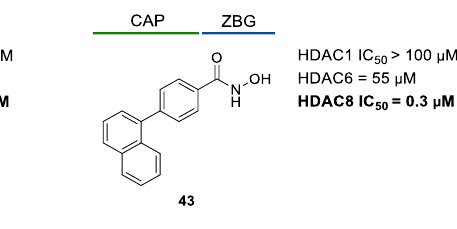
50 of 42 and 43